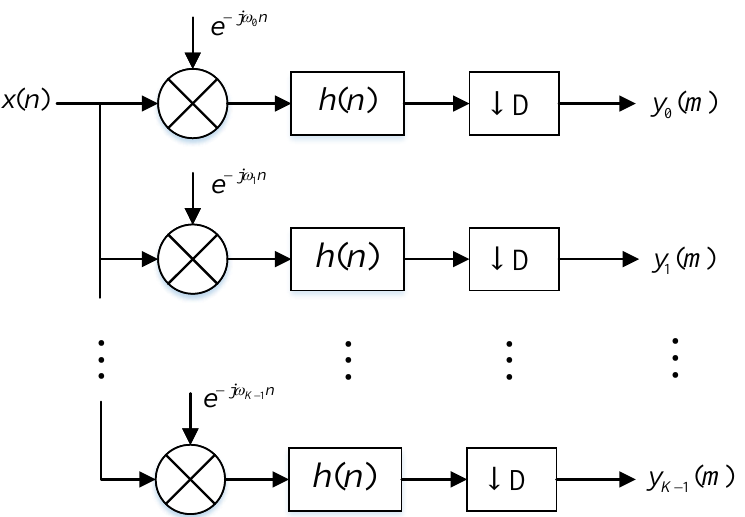
Figure 2. The complex signal down-conversion low-pass channelization